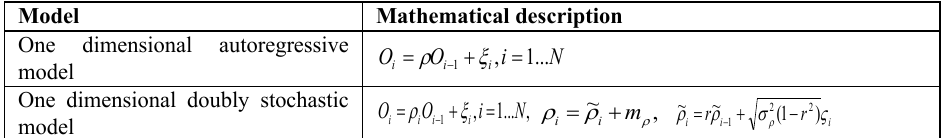
Table 1. Data Representation Stochastic Models Used